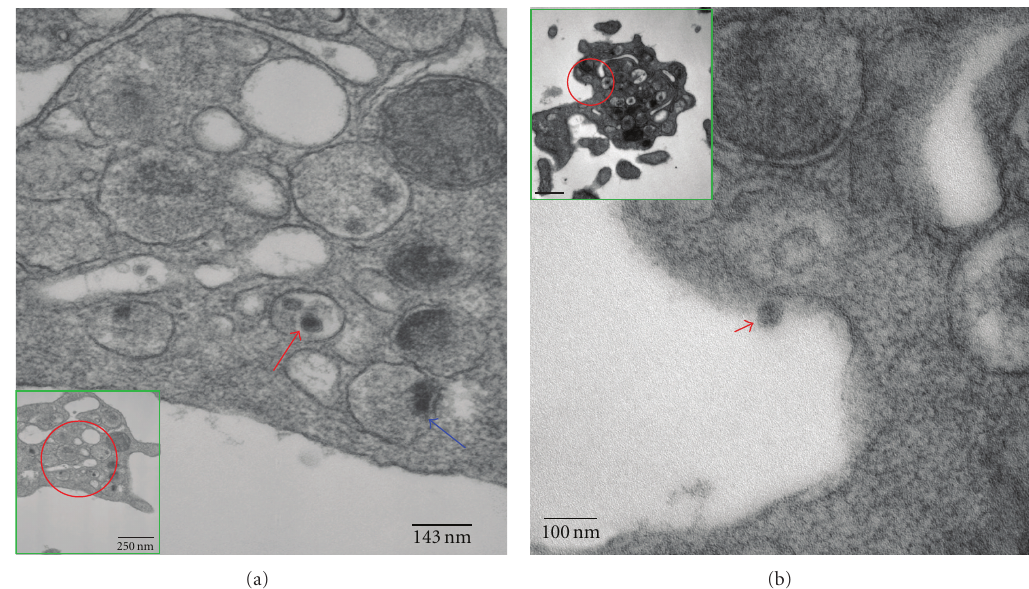
Figure 2: Dengue virus-like particles in platelets isolated from confirmed dengue patients . Platelets were isolated from confirmed dengue patients at the acute stage and subjected to electron microscopy. (a) Dengue virus-like particles were observed inside vesicle compartment (red arrow) and a particle appeared to be on its way budding out into the vesicle (blue arrow). (b) A single fuzzy virus-like particle was released from platelet (red arrow head). Red circle indicates the enlarged area. Insert is the